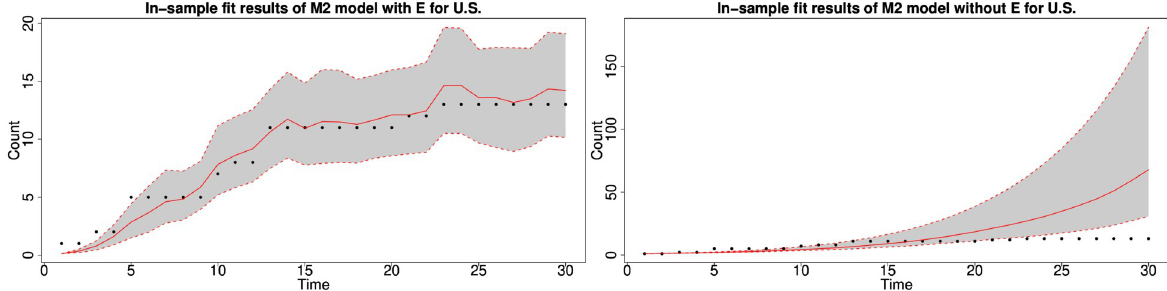
Fig 21. In-sample fit results with the sentiment exposure adjustment for the United States. In-sample fitting plot for the US by Model 2 for the first month with (left) and without (right) the sentiment exposure adjustment.